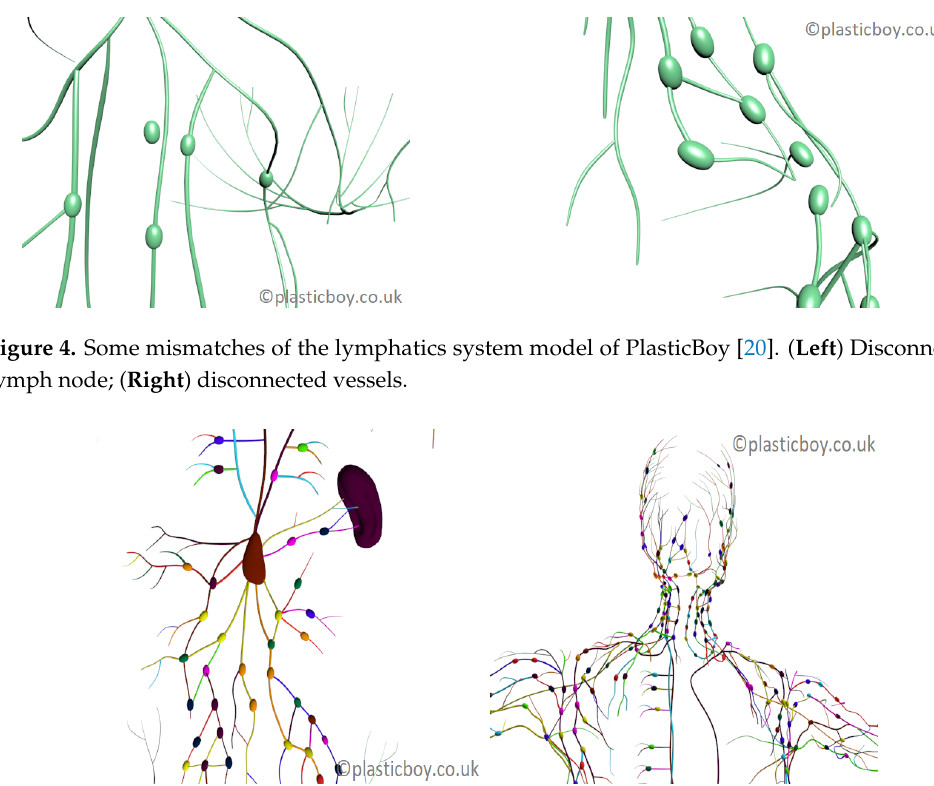
Figure 5. 3D polygonal surface model of the lymphatic system after removal of pendant vessels and differentiation of vessels. ( Left ) Spleen and vessels draining to cisterna chyli; ( Right ) head, neck, chest and armpits from PlasticBoy project